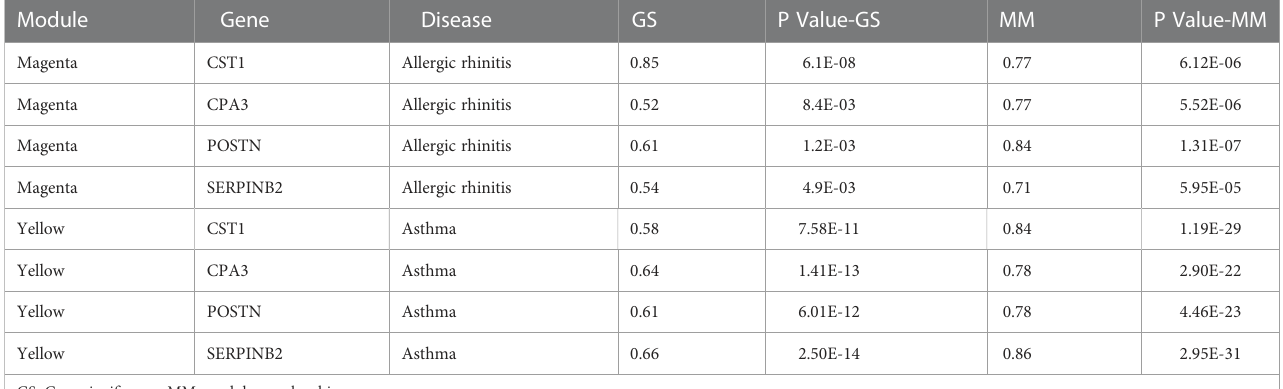
TABLE 2 Correlations between 4 key genes and diseases and modules.